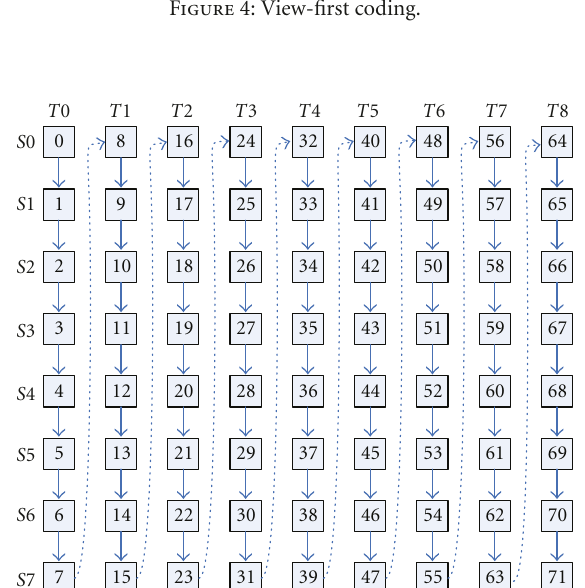
Figure 5: Time-first